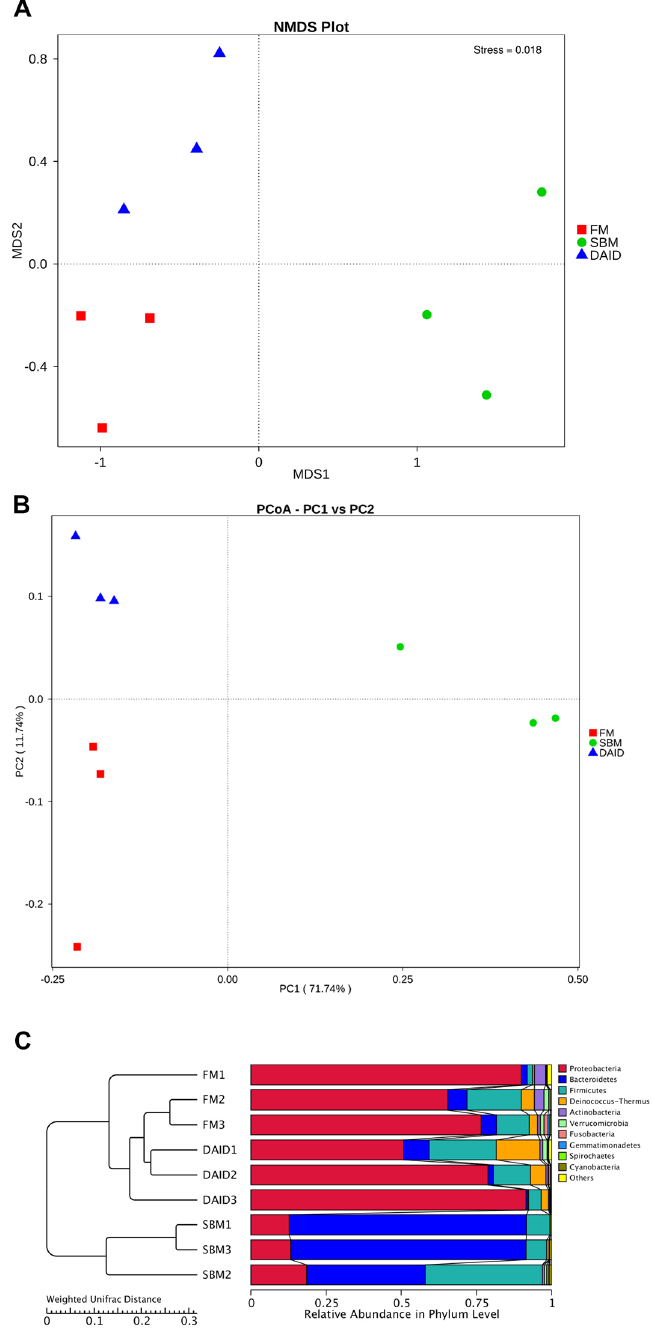
Figure 7. Beta diversity of intestinal microbiota of juvenile turbot. ( A ) non-metric multi-dimensional scaling (NMDS) analysis; ( B ) principal coordinate analysis (PCoA) based on weighted unifrac distances; ( C ) unweighted pair-group method with arithmetic mean (UPGMA)-clustering trees based on weighted unifrac distances. FM fish meal diet, SBM soybean meal diet, DAID 40 mg/kg daidzein included into SBM